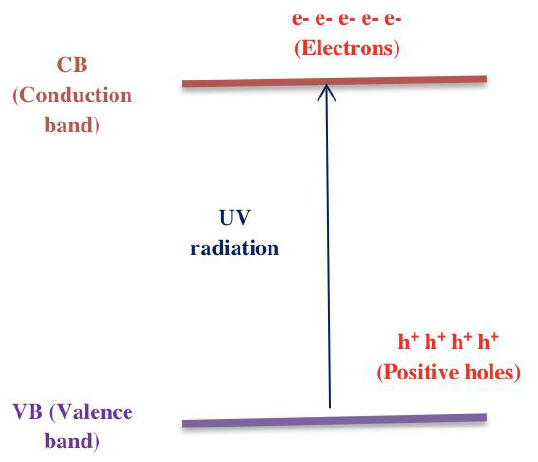
Figure 1. Band gap energy for different type of materials [50].